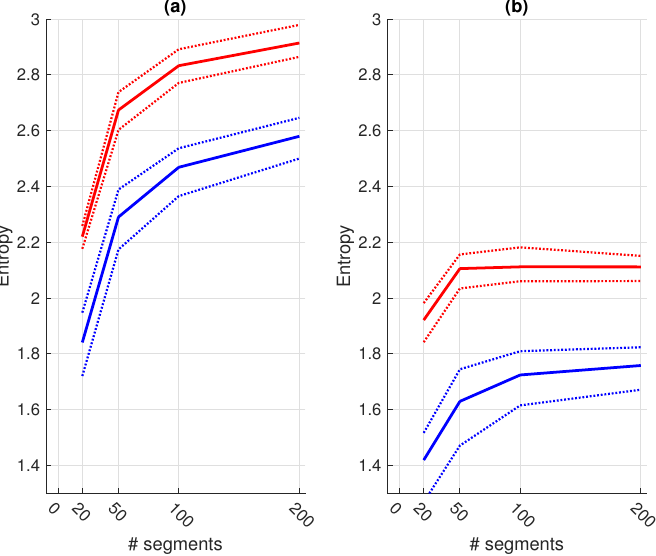
Figure 8. The difference in entropy for the clean ( a ) and noisy ( b ) samples of the CC subsets. The blue line indicates the random sampling and the red line indicates the fixed-size sampling approach. The full line indicates the median values and the dotted lines indicate the interquartile ranges. We can observe that the entropy is consistently higher for the fixed-size